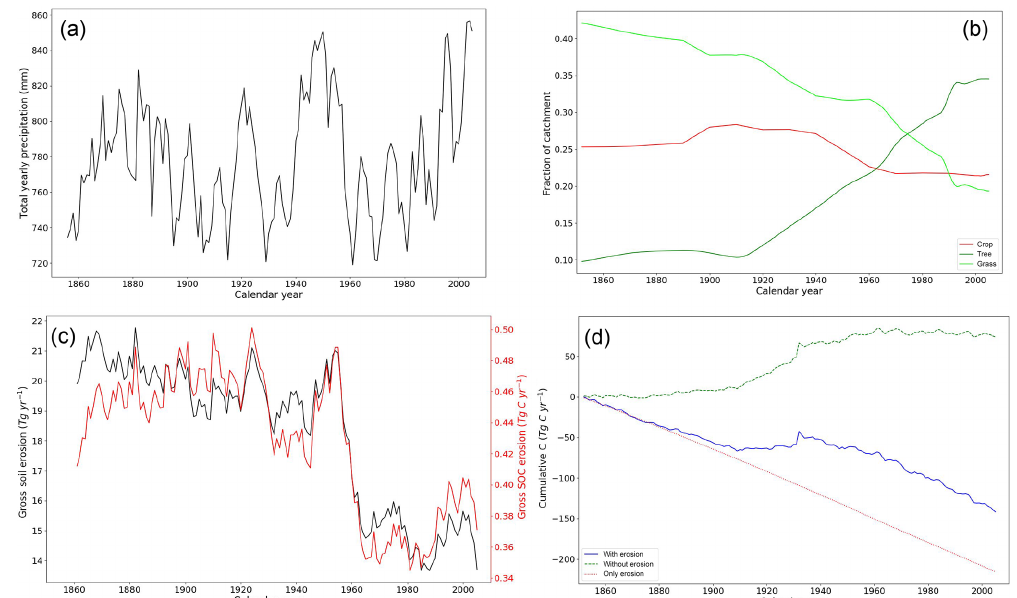
Figure 7. Time series of (a) the 5-year average yearly precipitation (mm), (b) changing land cover fractions, (c) 5-year average total gross soil erosion (Pgyr − 1 ) and total gross C erosion rates (TgCyr − 1 ) , and (d) cumulative C emissions from the soil to the atmosphere under land use change and climate change without soil erosion (dashed green line), with soil erosion (solid blue line), due to additional respiration or stabilization of buried soil and photosynthetic replacement of C under erosion ( E p , dotted red line). All graphs represent the non-Alpine region of the Rhine